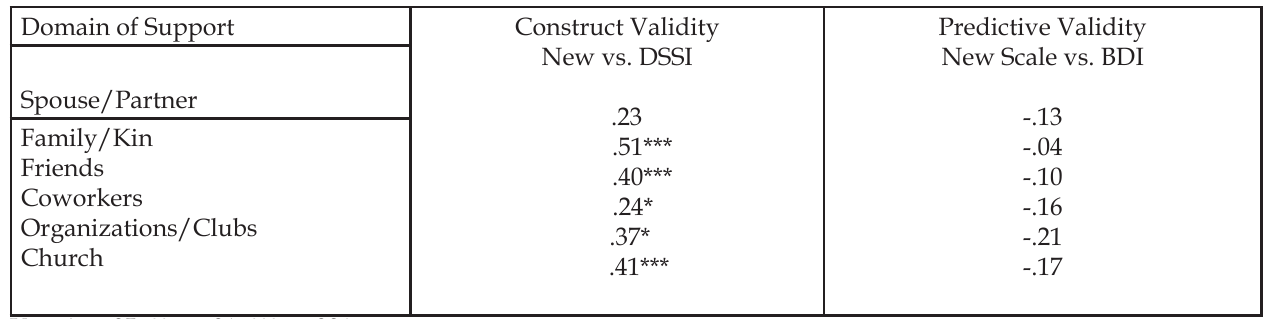
Table VII. Construct and predictive